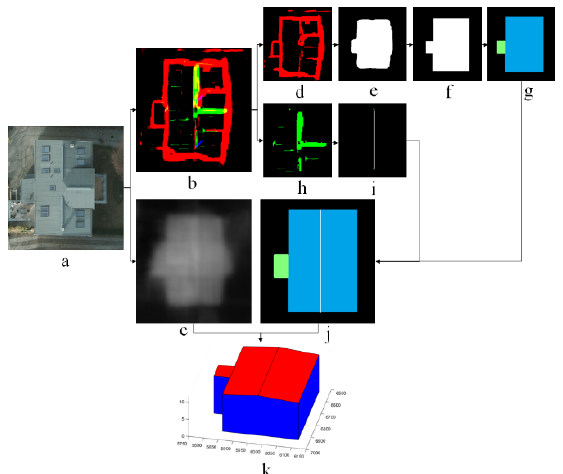
Figure 6. 3D reconstruction of individual building parts: a: the RGB image; b: the predicted rooflines; c: the predicted nDSM; d: the predicted eave lines, e: the binary polygon; f: the approximated polygon; g: the decomposed polygons; h: the predicted ridge lines; i: the best fitted ridge line; j: The final roof elements; k: 3D models of building parts